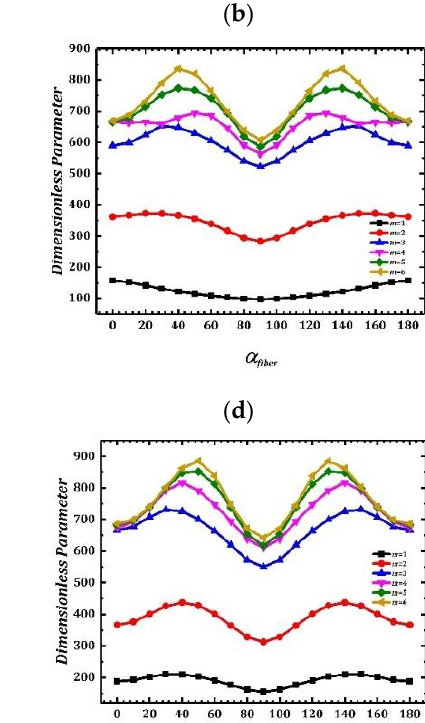
( f ) Figure 6. Variation of frequency parameter Ω versus thickness for an LCDCSS with classical bound- ary conditions. ( a ) CC-CC; ( b ) SS-SS; ( c ) FF-FF; ( d ) CS-CS; ( e ) CF-CF; ( f ) SF-SF. Figure 7 shows the variation of vibration characteristics of LCDCSS when the thick- ness coefficient of both cylindrical shell and annular plates changes simultaneously. The system parameters are as: α f iber = [0° 90° 0° 90°], L = 2 m, h a = 0.02~0.4, h i = 0.004 m, h o /h i = 1~20. From Figure 7, it can be found that the frequencies continue to rise with the increase of structural thickness, which shows that the larger the thickness, the system is more sta- ble. It shows that the geometric parameters affect the vibration characteristic stiffness ma- trix of the LCDCSS in a certain range, and the vibration characteristics of the system can be adjusted by changing the parameters, which has important practical significance for the performance control of double shell structure.